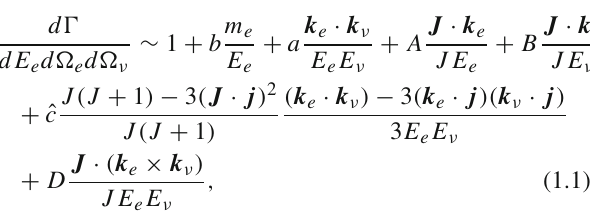
theoretical relation in Eq. (2.8) (the errors are small and are not relevant for the present study)